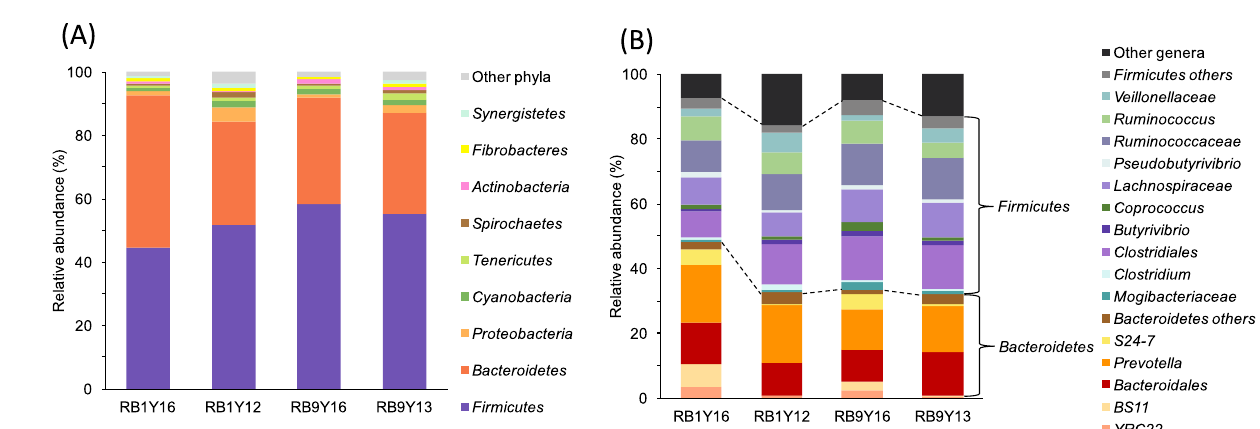
Figure 2. Yaku sika rumen bacterial community compositions at phylum level ( A ) and genus level ( B ). “Other phyla” contains several phyla with < 1% relative abundance. “Other genera” contains several genera among other